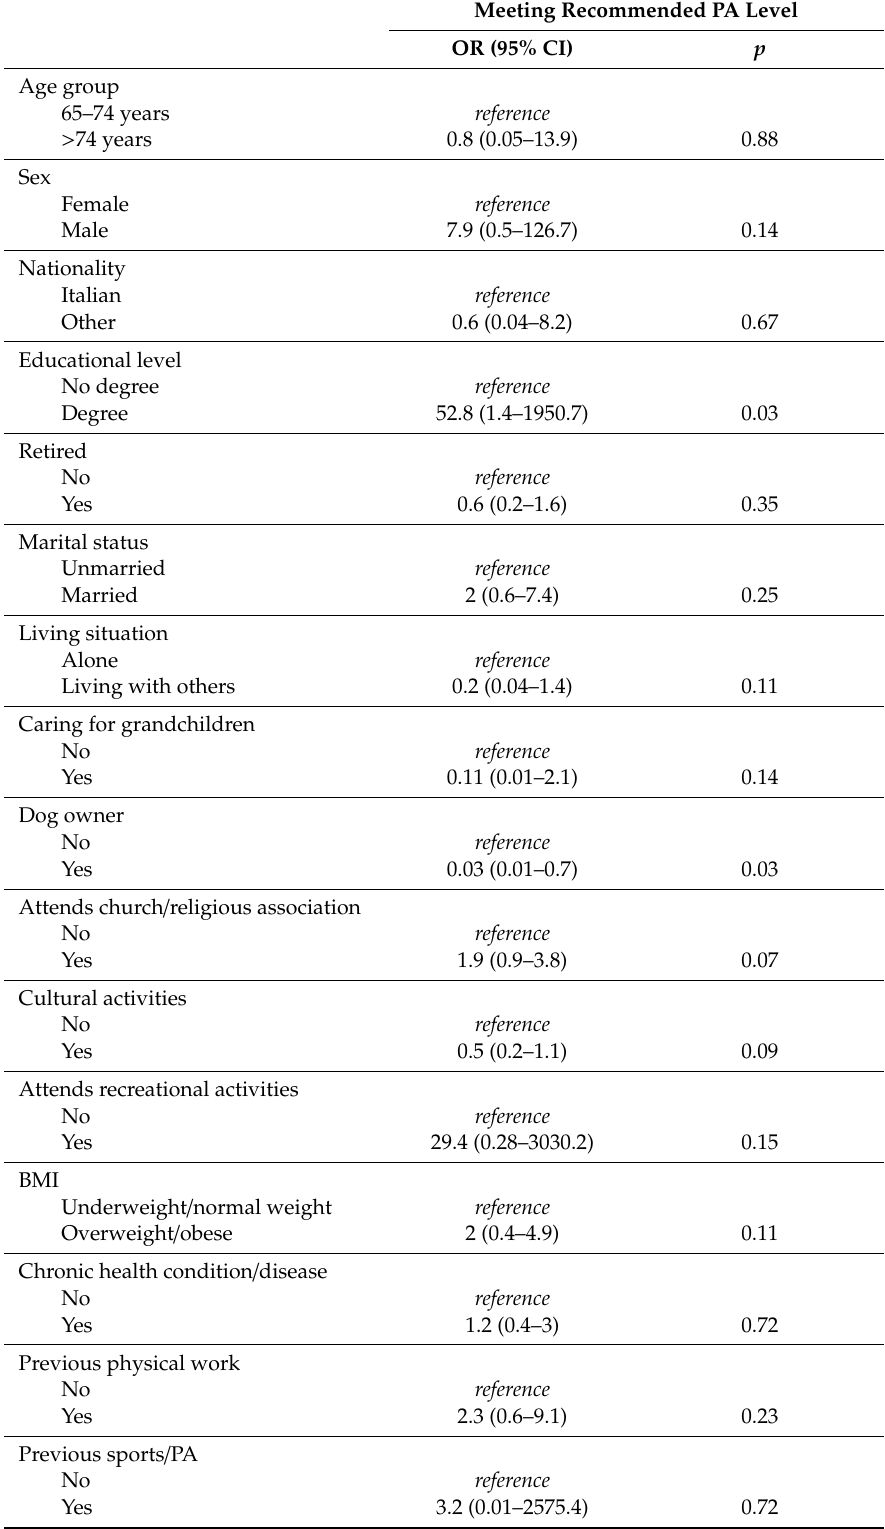
Table 4. Results of the multinomial logistic regression for the achievement of recommended weekly PA level as the